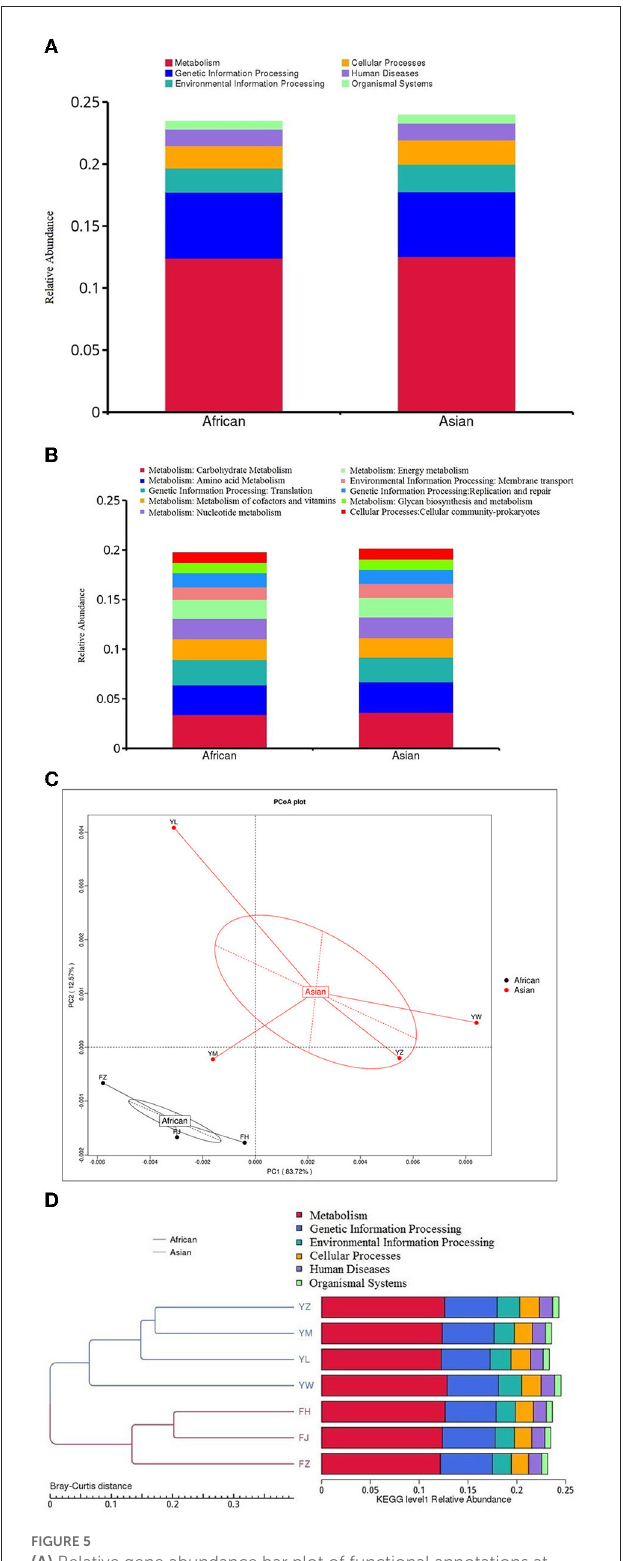
FIGURE5 (A) Relative gene abundance bar plot of functional annotations at level1in KEGG database; (B) Relative gene abundance histogram of top ten functional annotations at level 2 in KEGG database in African ( n = 3) and Asian ( n = 4) elephants. (C) PCoA analysis of functional gene abundance at level 1 in KEGG database based on Bray-Curtis distance (D) Clustering tree based on Bray-Curtis distance (the left side is the clustering tree structure; the right side is the functional relative abundance distribution of each sample at the first level of KEGG).